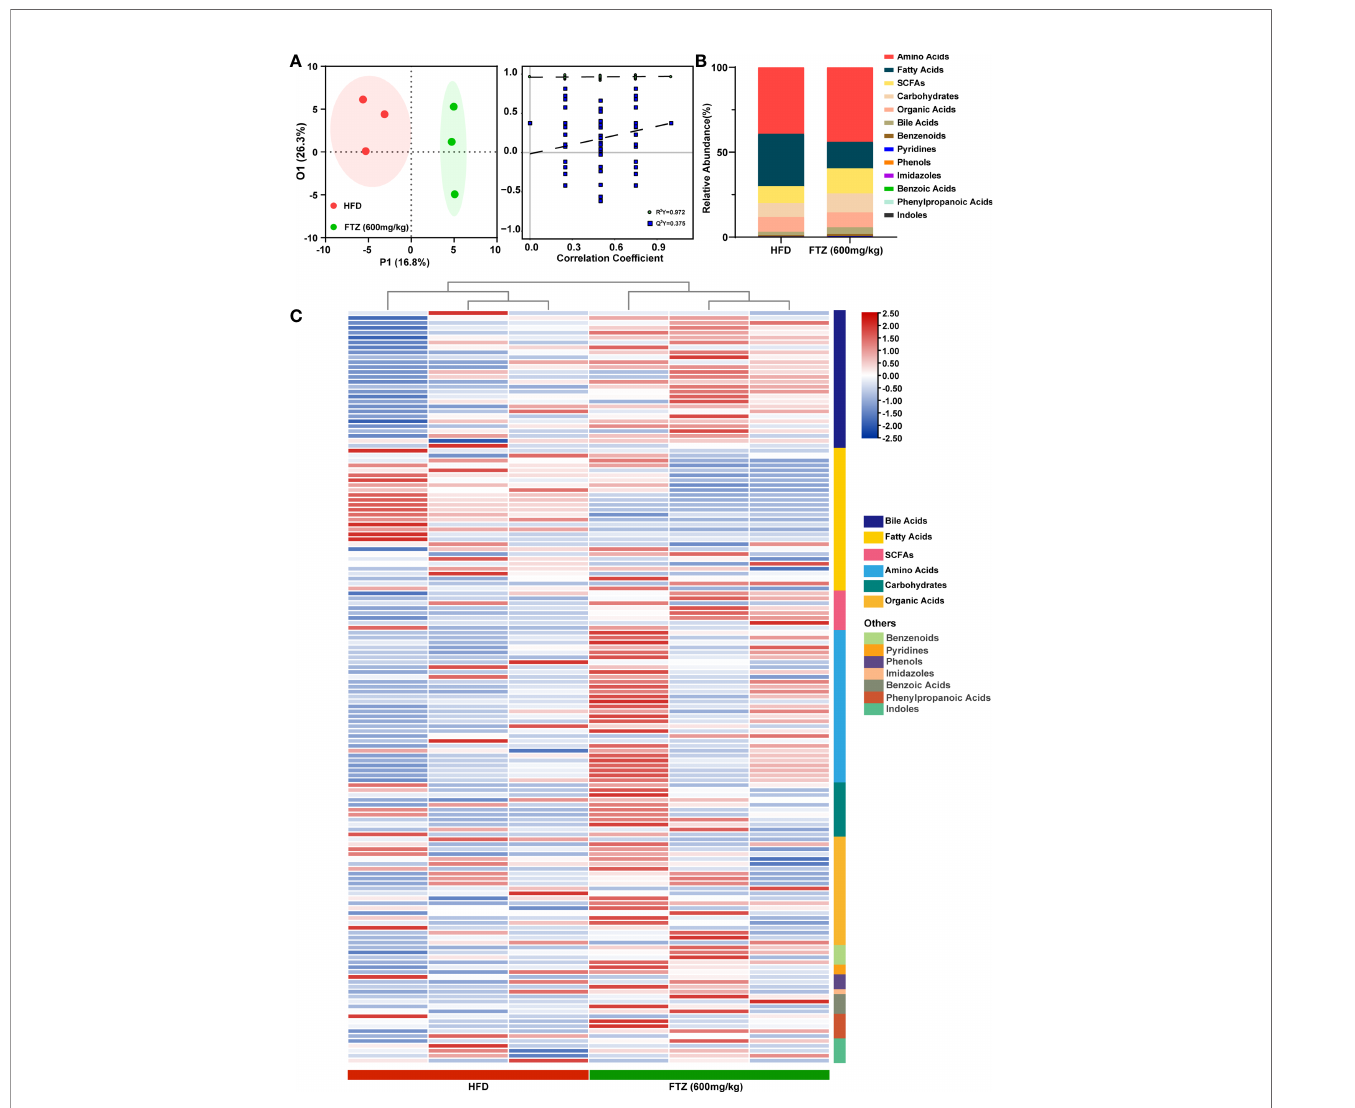
FIGURE 7 | Effects of FTZ on the metabolite composition of the intestinal fl ora of mice. (A) OPLS-DA 2D score chart and permutation test (n=3). (B) Relative abundance statistics for the median values of each metabolite in each group of samples. (C) Z-score heat map for the overall metabolite pro fi le